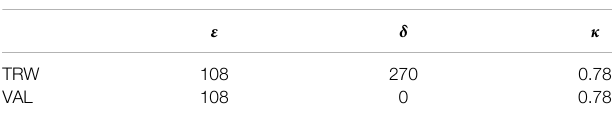
TABLE 1 | The parameters used in the theoretical model of geomagnetic eclipse- disturbance: ϵ is the angle between x -axis (to geographic North) and E 0 ; δ is the distance from the observatories and the center of the eclipse-induced conductivity spot (in km), and κ is the degree of the VTEC decrement caused by the solar